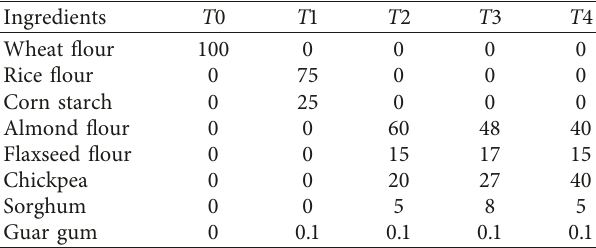
Table 1: Formulation and ingredients of various gluten-free cupcakes and control